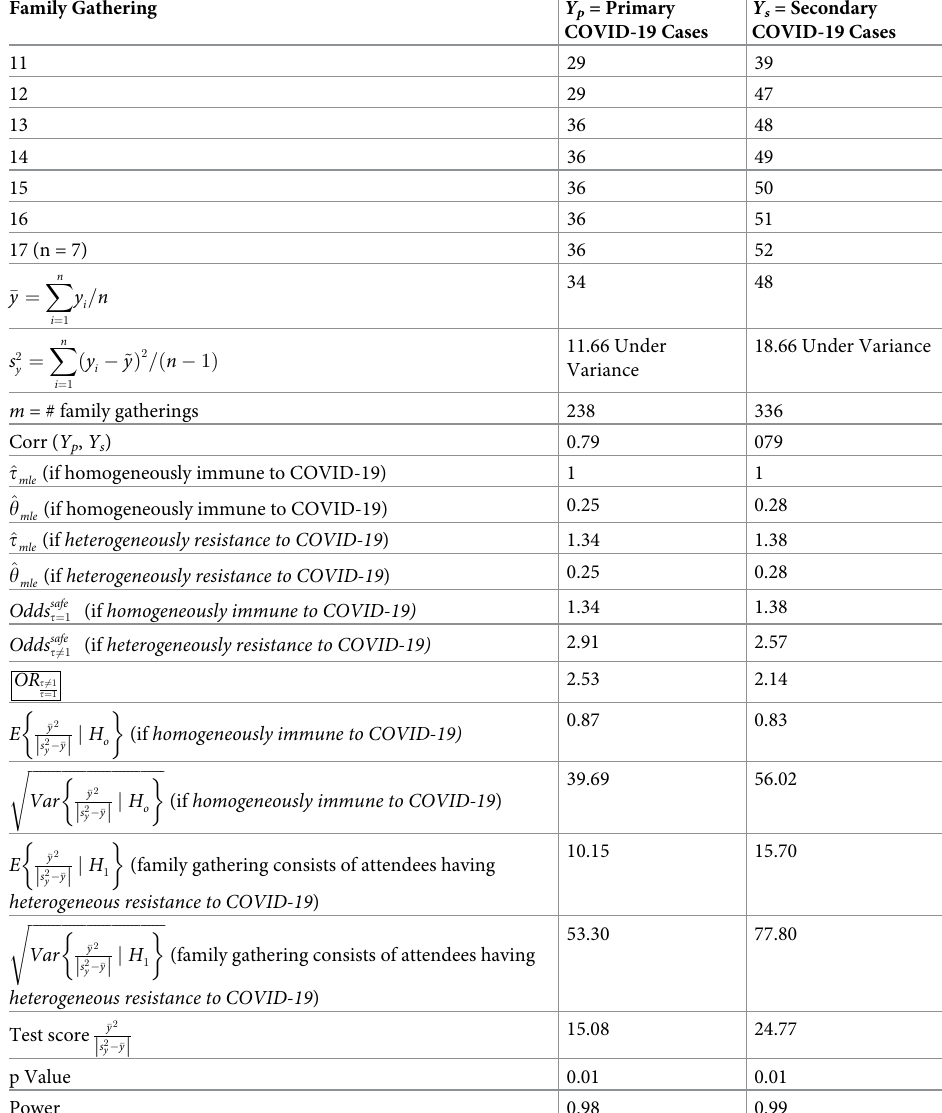
Table 2. The family gathering in which the primary cases were in double digits (with under variance). Family